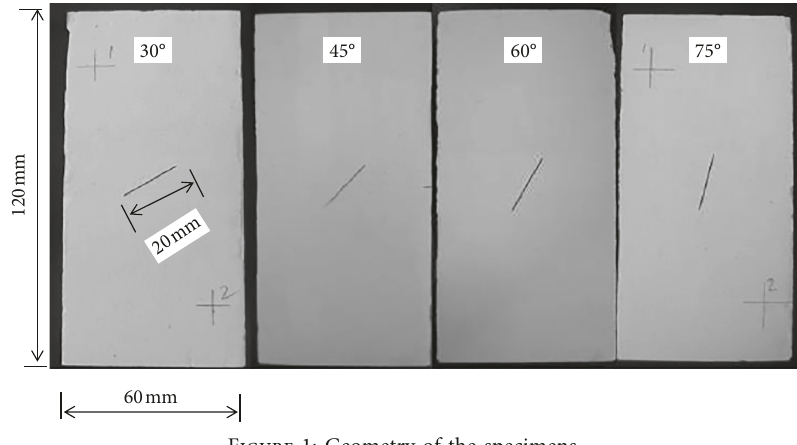
Figure 1: Geometry of the specimens. Table 1: Physical and mechanical parameters of the specimen.